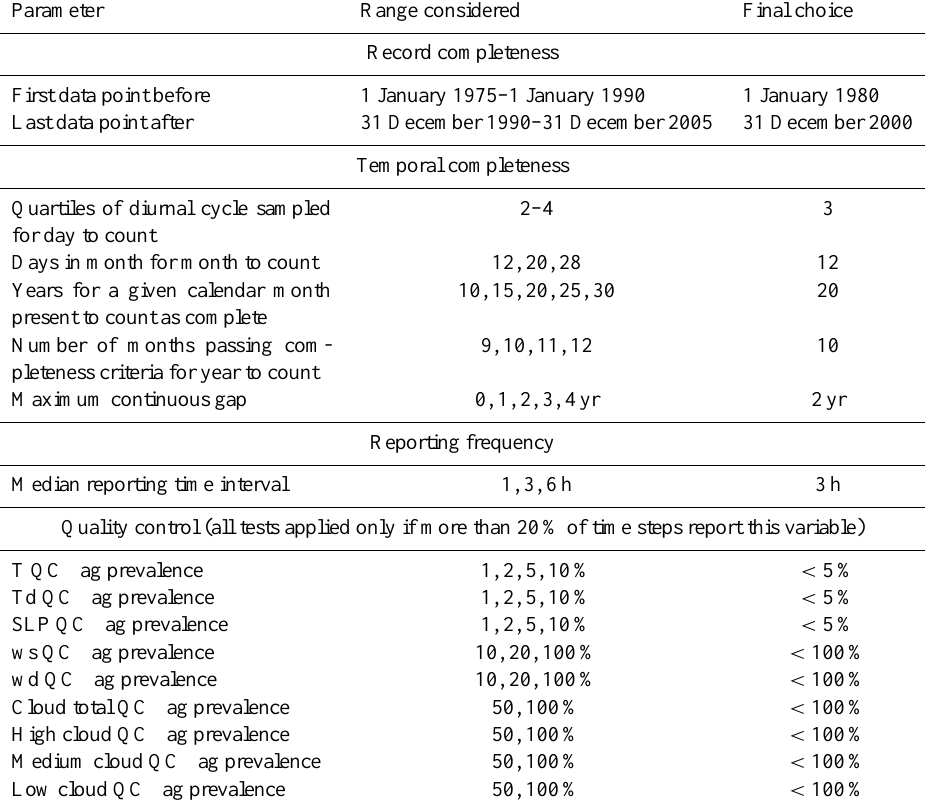
Table 8. Station inclusion criteria: ranges considered and final choices. Note that there has been no selection on the wind or cloud variables. These variables have not been the focus of the QC procedure; we therefore do not exclude stations which have valid temperature, dewpoint and pressure data on the basis of their wind and cloud data quality.